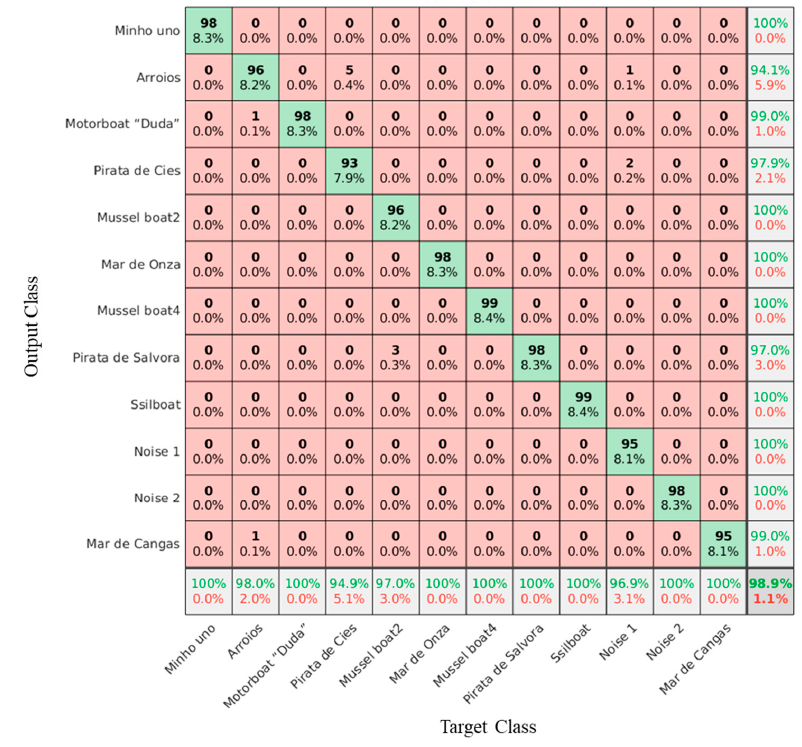
Figure 9. Confusion matrix of 12 different specific